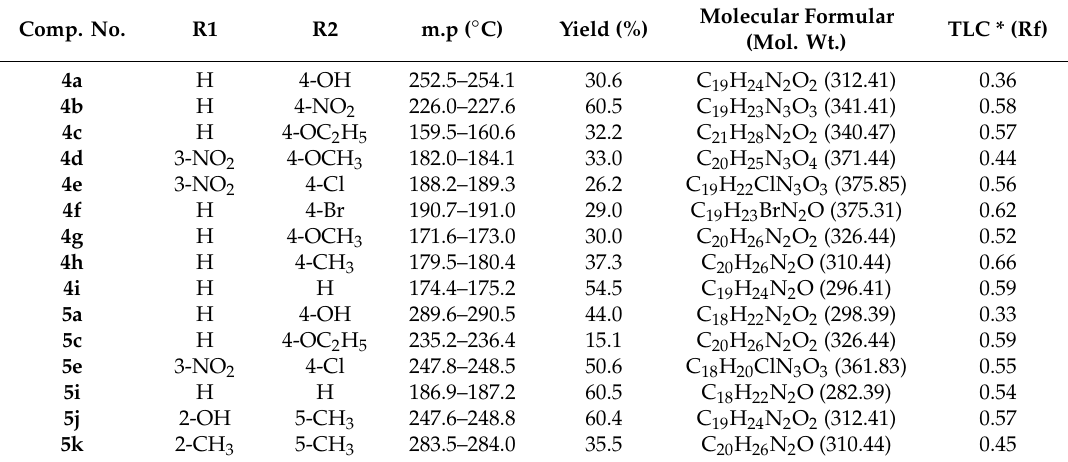
Table 1. Melting point (m.p), yield (%), molecular formulae, molecular weight (Mol. Wt.) and Rf of hydrazide-hydrazones 4a – i and 5a – k . Comp. No.